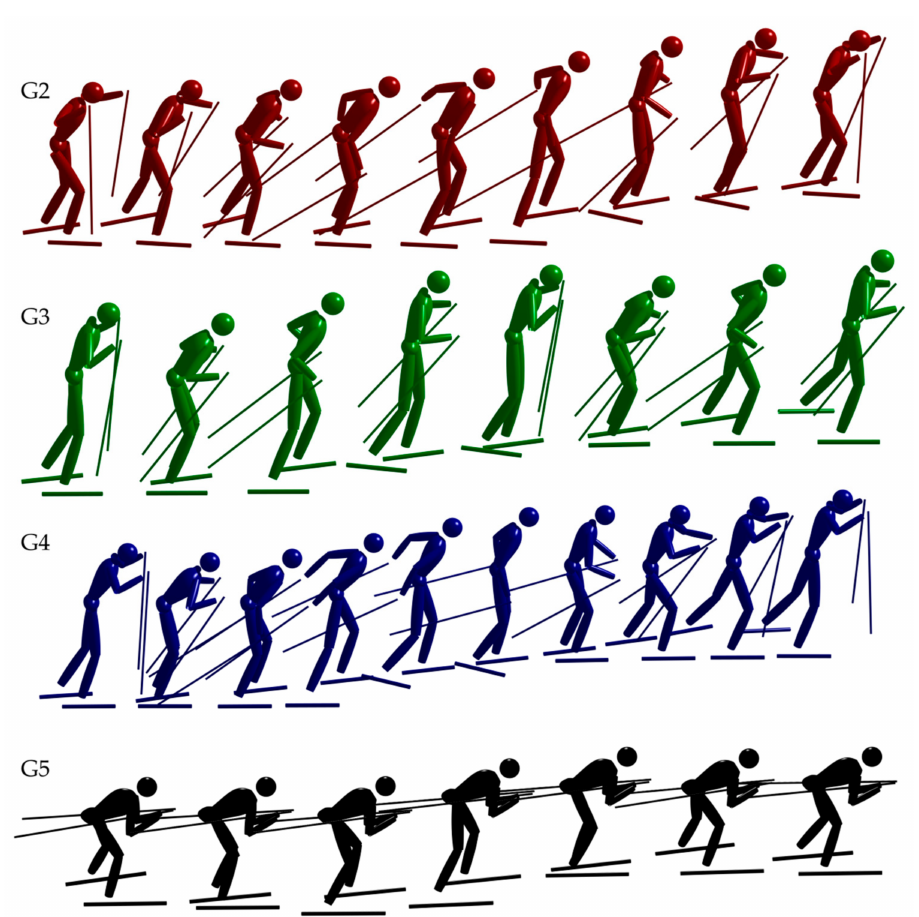
Figure 1. Illustration of one movement cycle of the ski-skating sub-techniques termed G2–G5. G2 and G4 consists of one poling cycle per movement cycle and can therefore be executed in left or right symmetric variants—this figure shows only the right symmetric variants. G3 and G5 have two or zero poling cycles per movement cycle, respectively, and do not have left/right symmetric variants. The color coding with red indicating G2, green indicating G3, and blue indicating G4 is used consistently throughout the